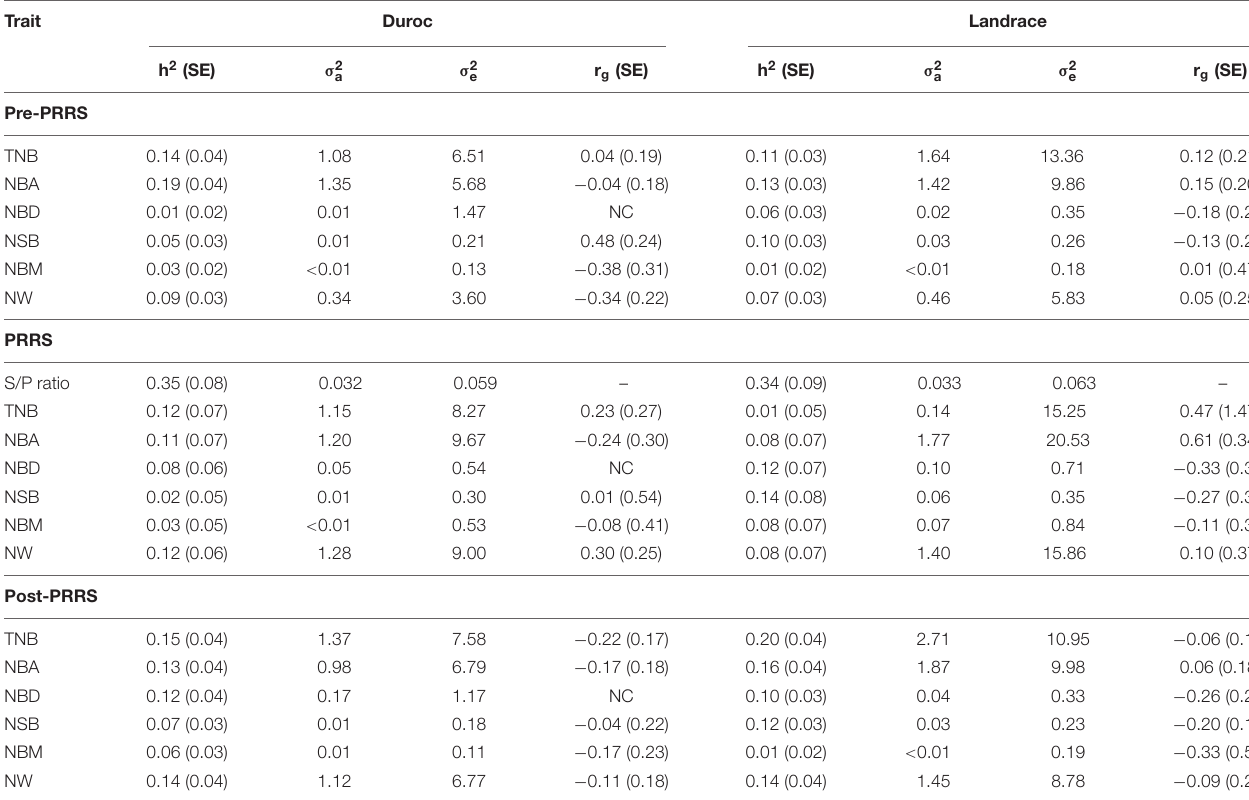
TABLE 1 | Heritability estimates (SE) and variance components of traits and their genetic correlation ( r g ) with sample-to-positive (S/P) ratio for each PRRS phase and breed. Trait Duroc